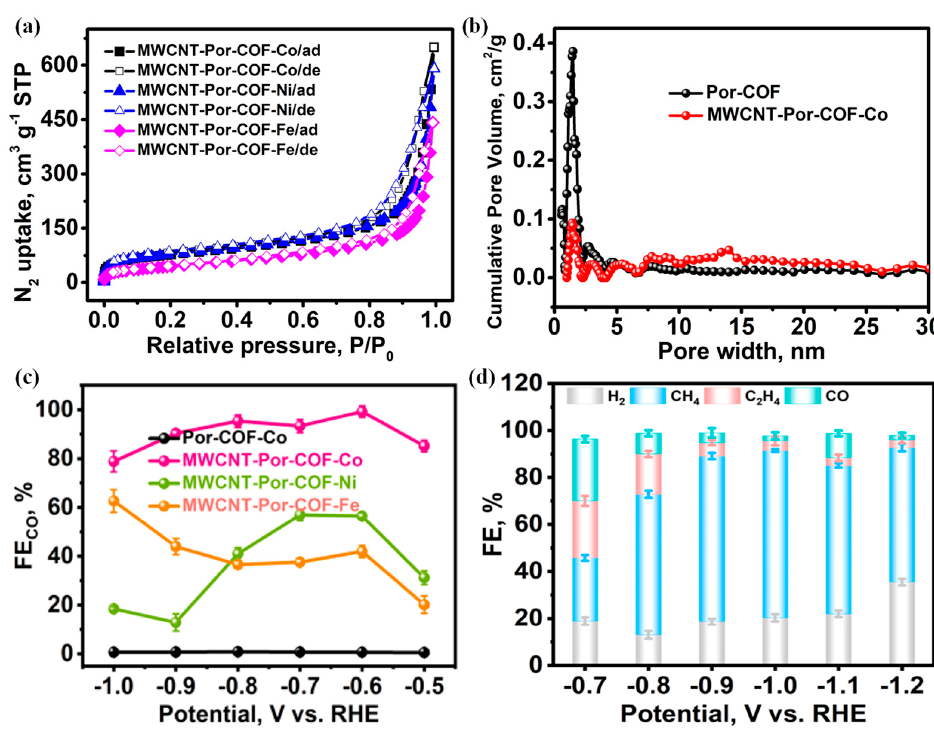
Figure 12. ( a ) BET plot of MWCNT − Por − COF-Cu at 77K; ( b ) Pore distribution of MWCNT − Por − COF − Co and Por − COF; ( c ) Faraday efficiency potentials in the range of − 0.5 to − 1.0 V for CO; ( d ) Products obtained by electrocatalysis of MWCNT − Por − COF − Cu [95]. Reprinted with permission from Ref. [95]. Copyright 2022 Copyright Elsevier (Amsterdam, The Netherlands). Table 4. Summary of catalytic performance of COF catalysts in CO 2 electroreduction.